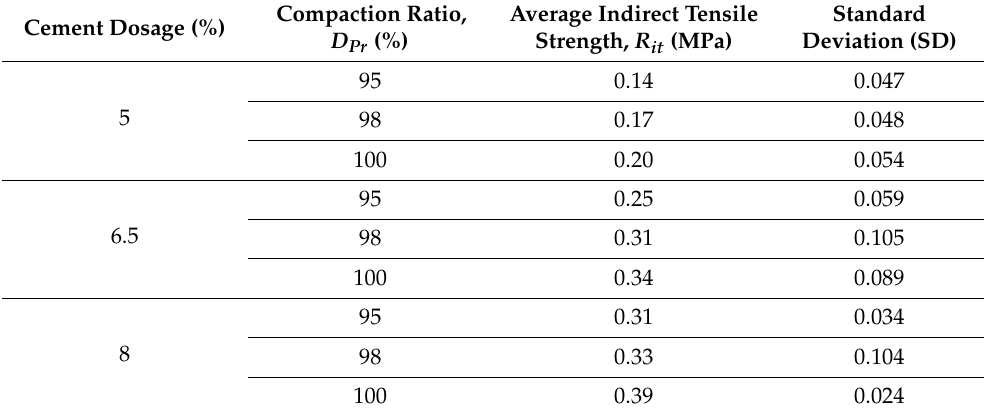
Table 4. Test results: indirect tensile strength, R it , under different compaction ratios and cement dosages.